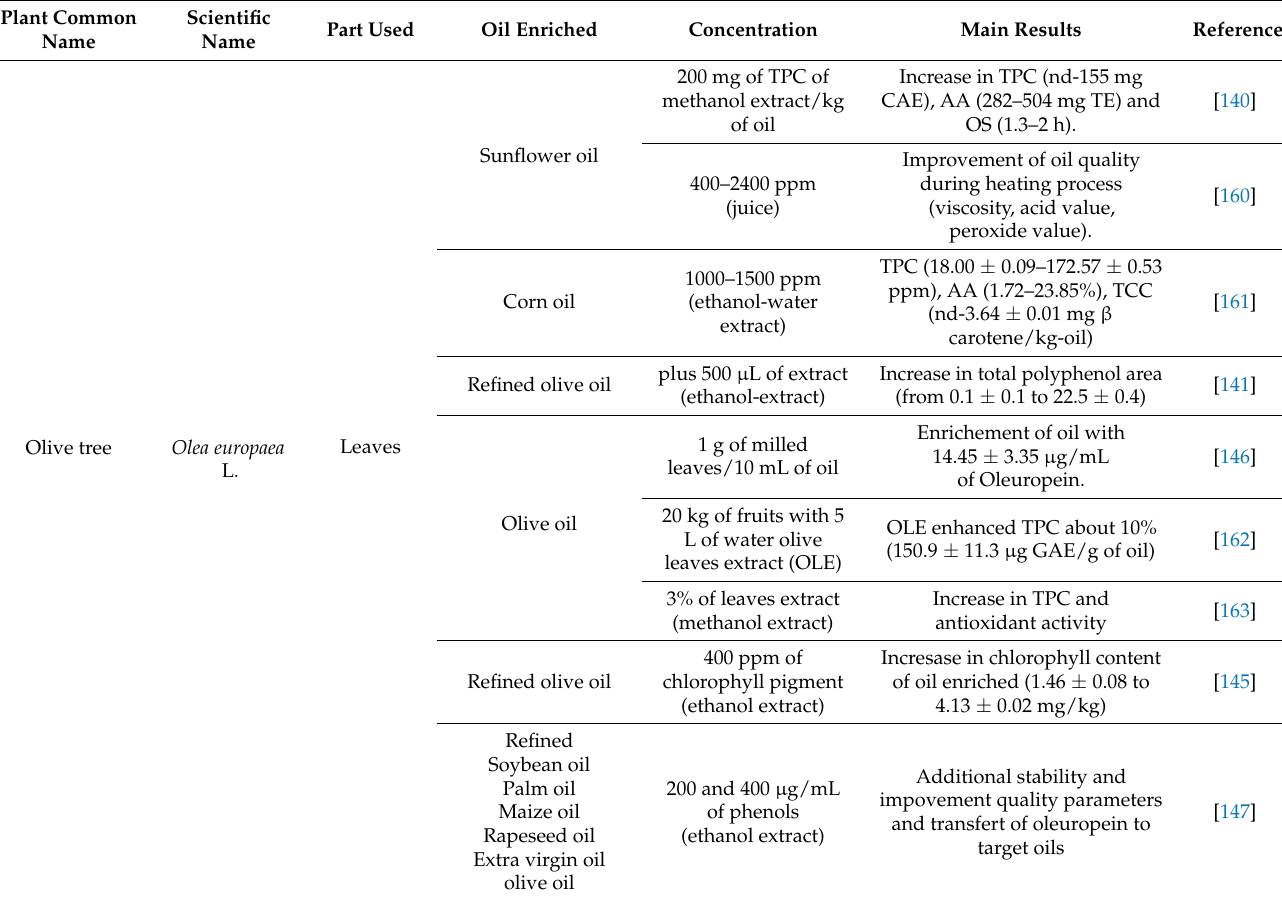
Table 3. Most plants used for vegetable oils